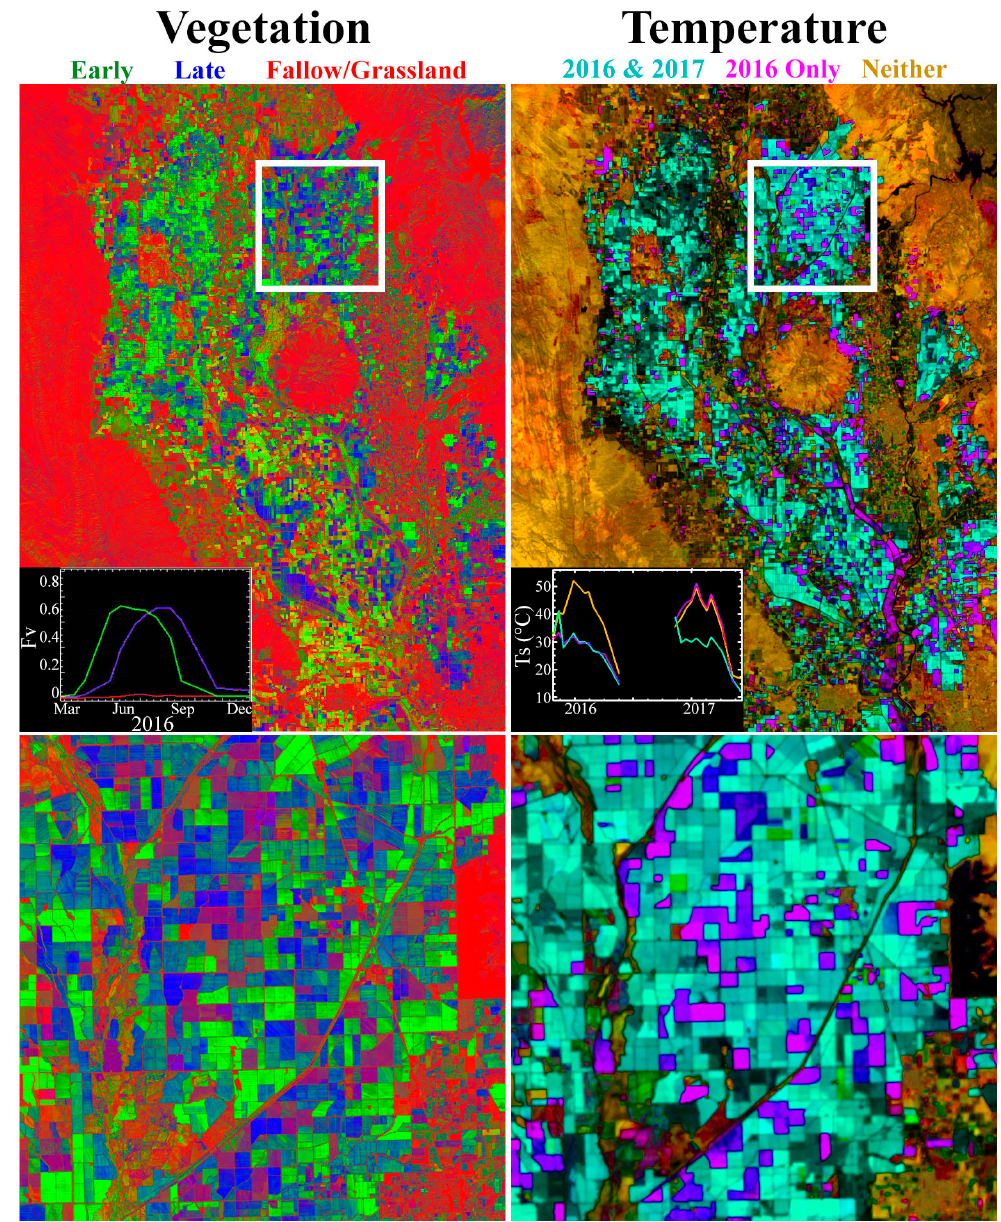
Figure 6. Temporal mixture model comparison. Each pixel time series can be modeled as a simple linear mixture of the EM time series derived from each TFS. Resulting EM fraction images can then be rendered as maps of temporal patterns. The EMs in the 2016 F v TFS clearly separate phenologic phase shifts, resulting in a map (L column) of early (green) versus late (blue) versus bare/grassland (red) crops for the 2016 growing season. The TMM based on F v cannot distinguish between rice and non-rice crops with the same phenological timing. The EMs of the 2016+2017 LST TFS discriminate between rice and non-rice because the flooded rice paddies are significantly colder than the bare fields present before non-rice crops are planted. The dual-year LST TMM (R column) shows year-to-year crop transitions. Fields planted with rice in both years (cyan) are clearly distinct from those planted only in 2016 (magenta), and those bare or grassland in both years (orange). The top row shows a regional map, while the bottom row shows a 24x24 km spatial subset (area within box) at full pixel resolution. Time series of the EMs displayed in each model are inset.